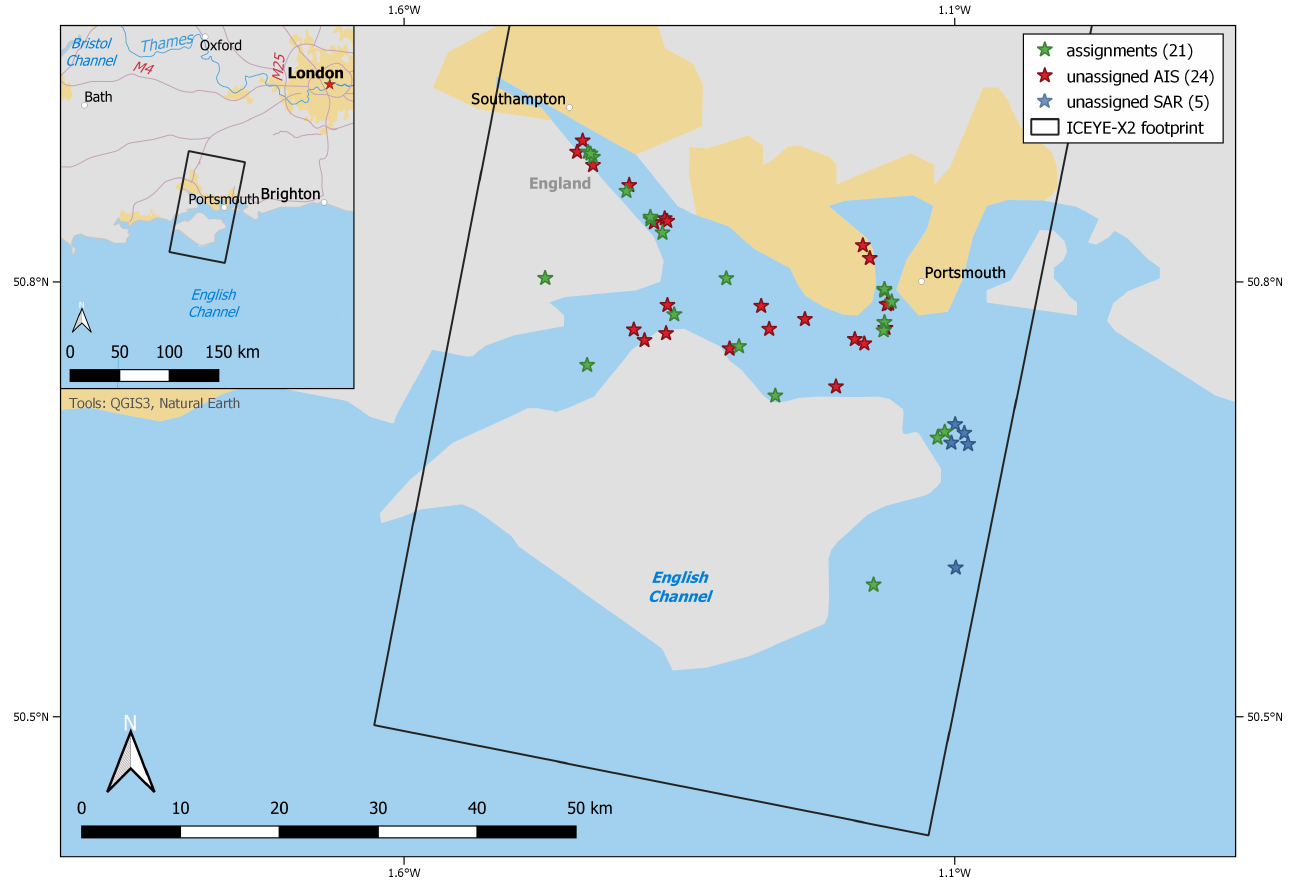
Figure 17. The Solent data